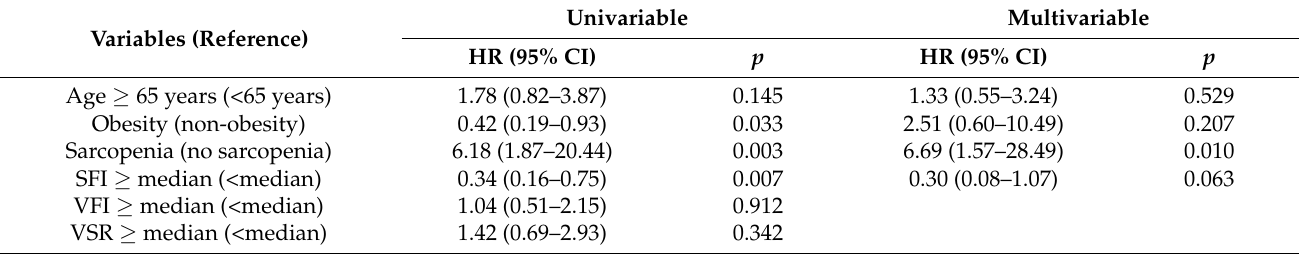
Table 2. Results of Cox regression analysis for failure-free